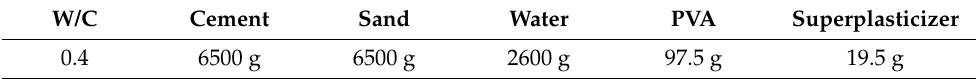
Table 1. Concrete Mix Proportion.